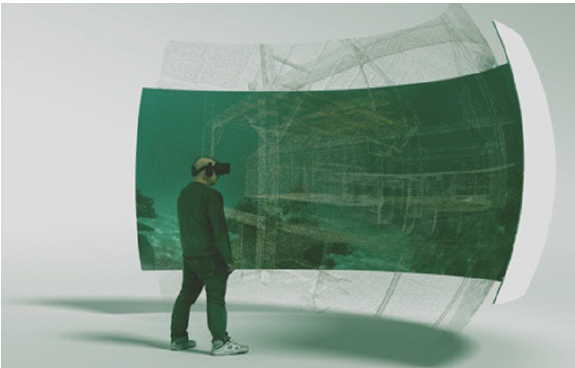
Figure 3. Panoramic Speculative Reconstruction of Lot